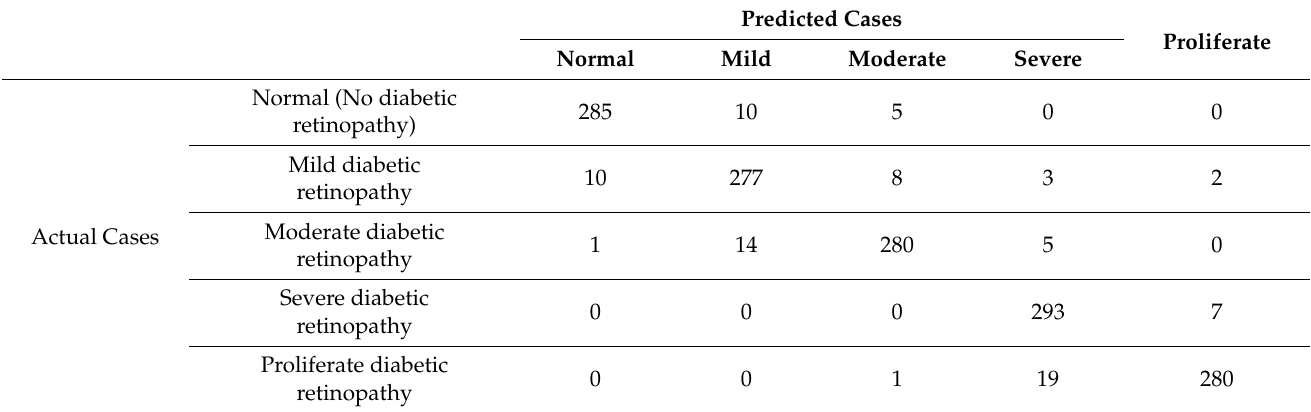
Table 8. Confusion matrix for the